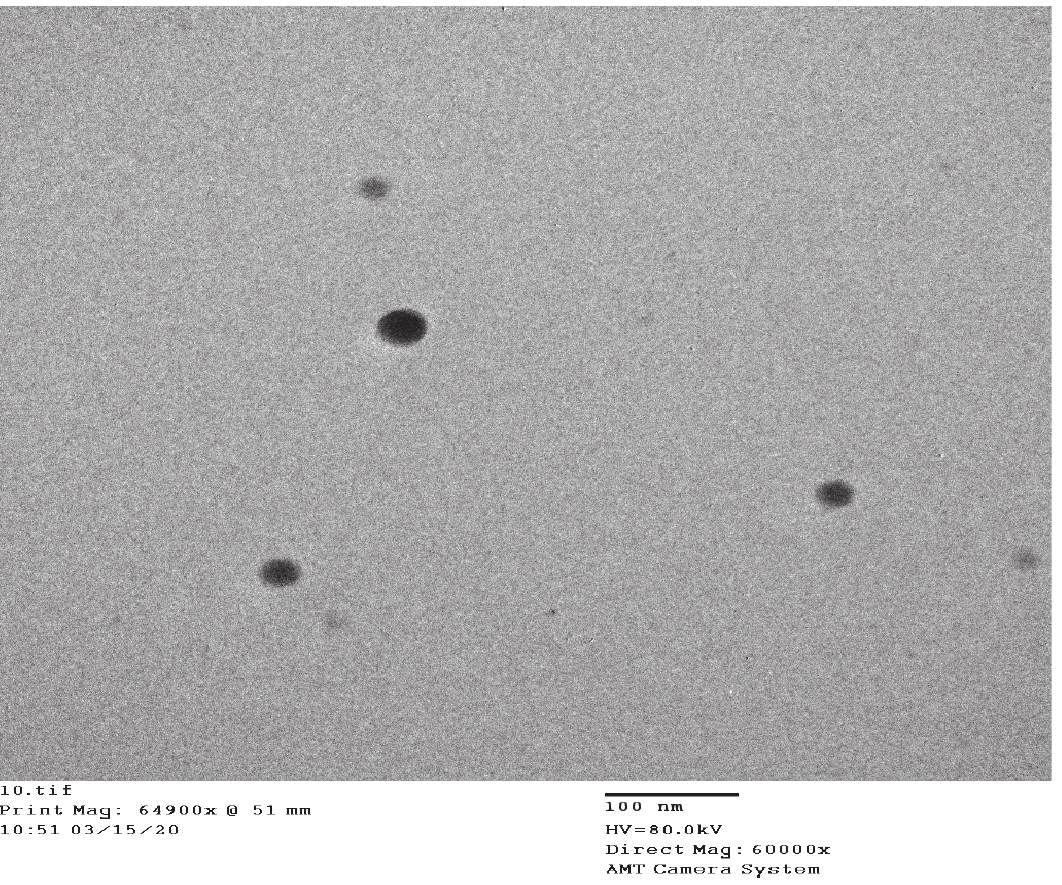
Figure 4. Droplet morphology of optimized nanoemulsion (NE4) system under transmission electron microscopy.